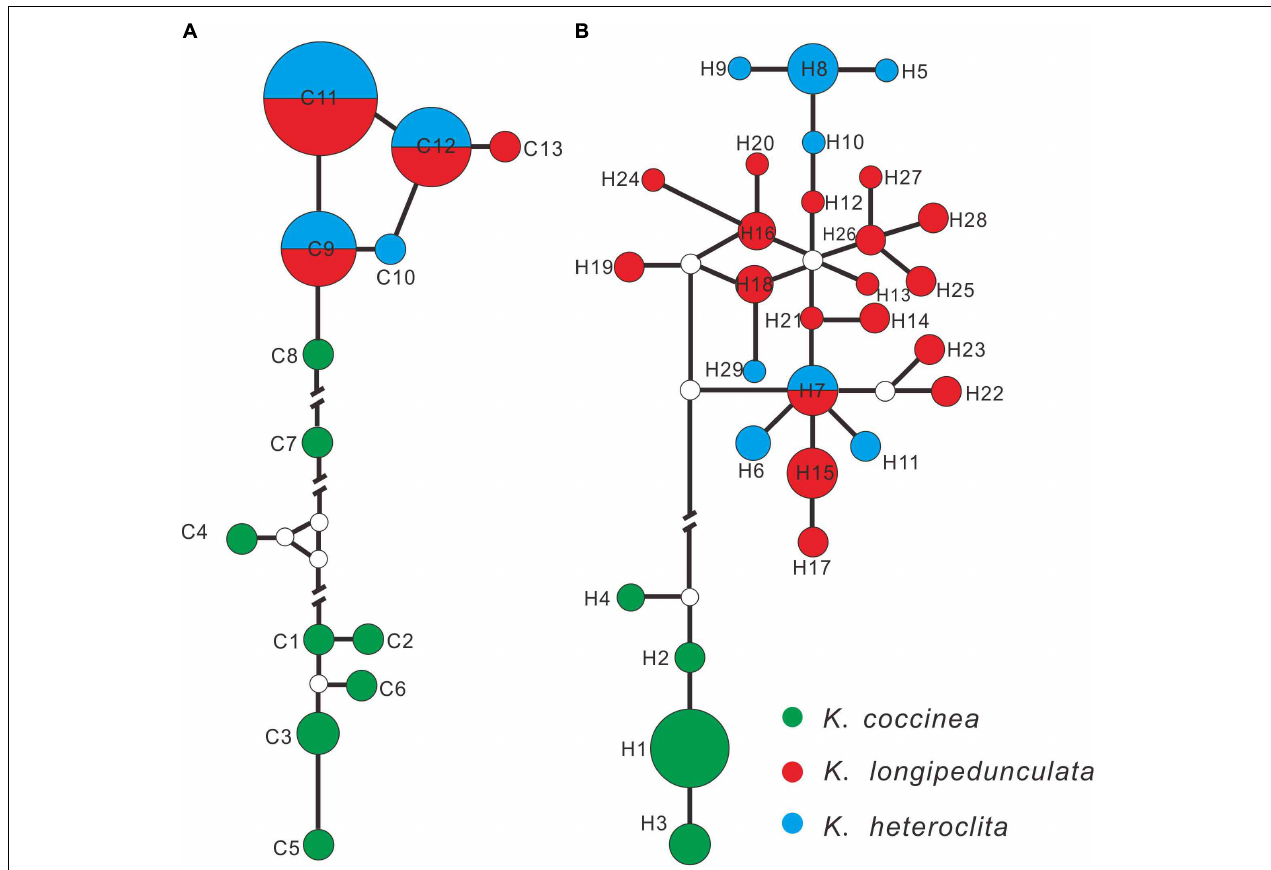
FIGURE 2 | Networks of the cpDNA (A) and ITS (B) haplotypes constructed by using NETWORK 5.0.0.1. The sizes of the circles in the network are proportional to the observed frequencies of the haplotypes.